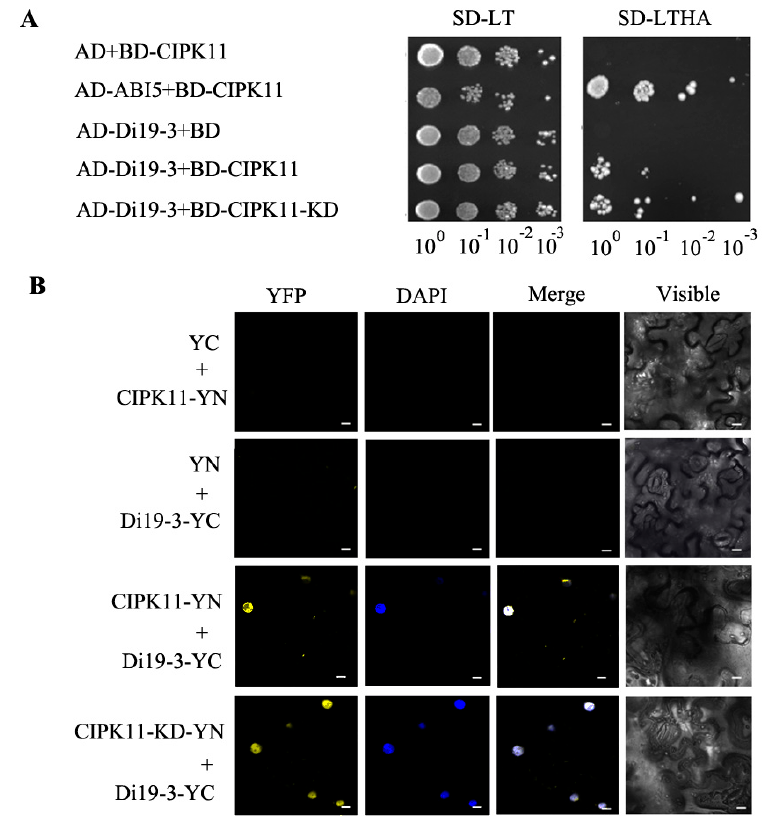
Figure 3. CIPK11 interacts with dehydration-induced19-3 (Di19-3). ( A ) Interaction between Di19-3 and CIPK11 was further confirmed by yeast-two-hybrid assay. Interaction was indicated by growth on selection medium (SD-LTHA) (right). Growth on SD-LT was used as control (left). SD-LT, SD / Trp / Leu media; SD-LTHA, SD / Trp / Leu / His / Ade media. ( B ) CIPK11 interacts with Di19-3 in vivo. Co-transformation of CIPK11-YN and Di19-3-YC led to the reconstitution of YFP signal, CIPK11-KD-YN and Di19-3-YC also led to the reconstitution of YFP signal whereas no signal was detected when CIPK11-YN and YC or Di19-3-YC and YN were co-expressed. The images were obtained from the yellow fluorescent protein channel or bright field, or a merged picture of the two. YFP images, DAPI stained images, visible light images, and merged images were taken. Scale bar = 10 µ m. The experiments were performed twice with similar results.